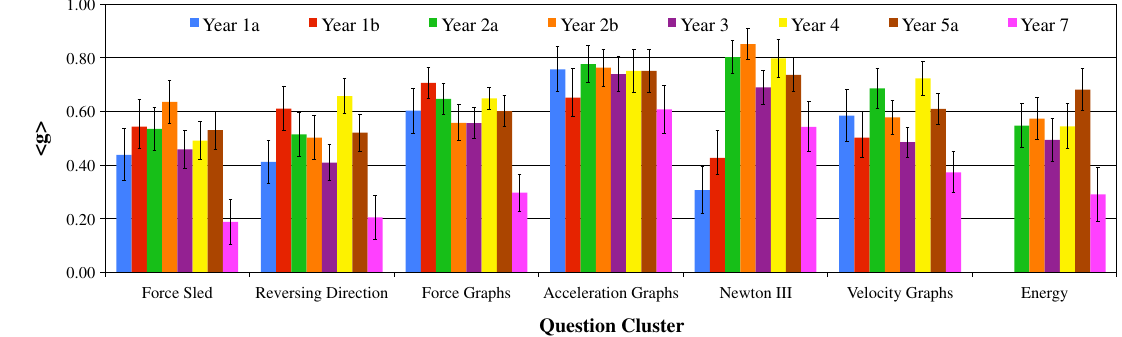
FIG. 6. Normalized gains for school 2 for each question cluster on the FMCE. Error bars are the standard error of the gain.